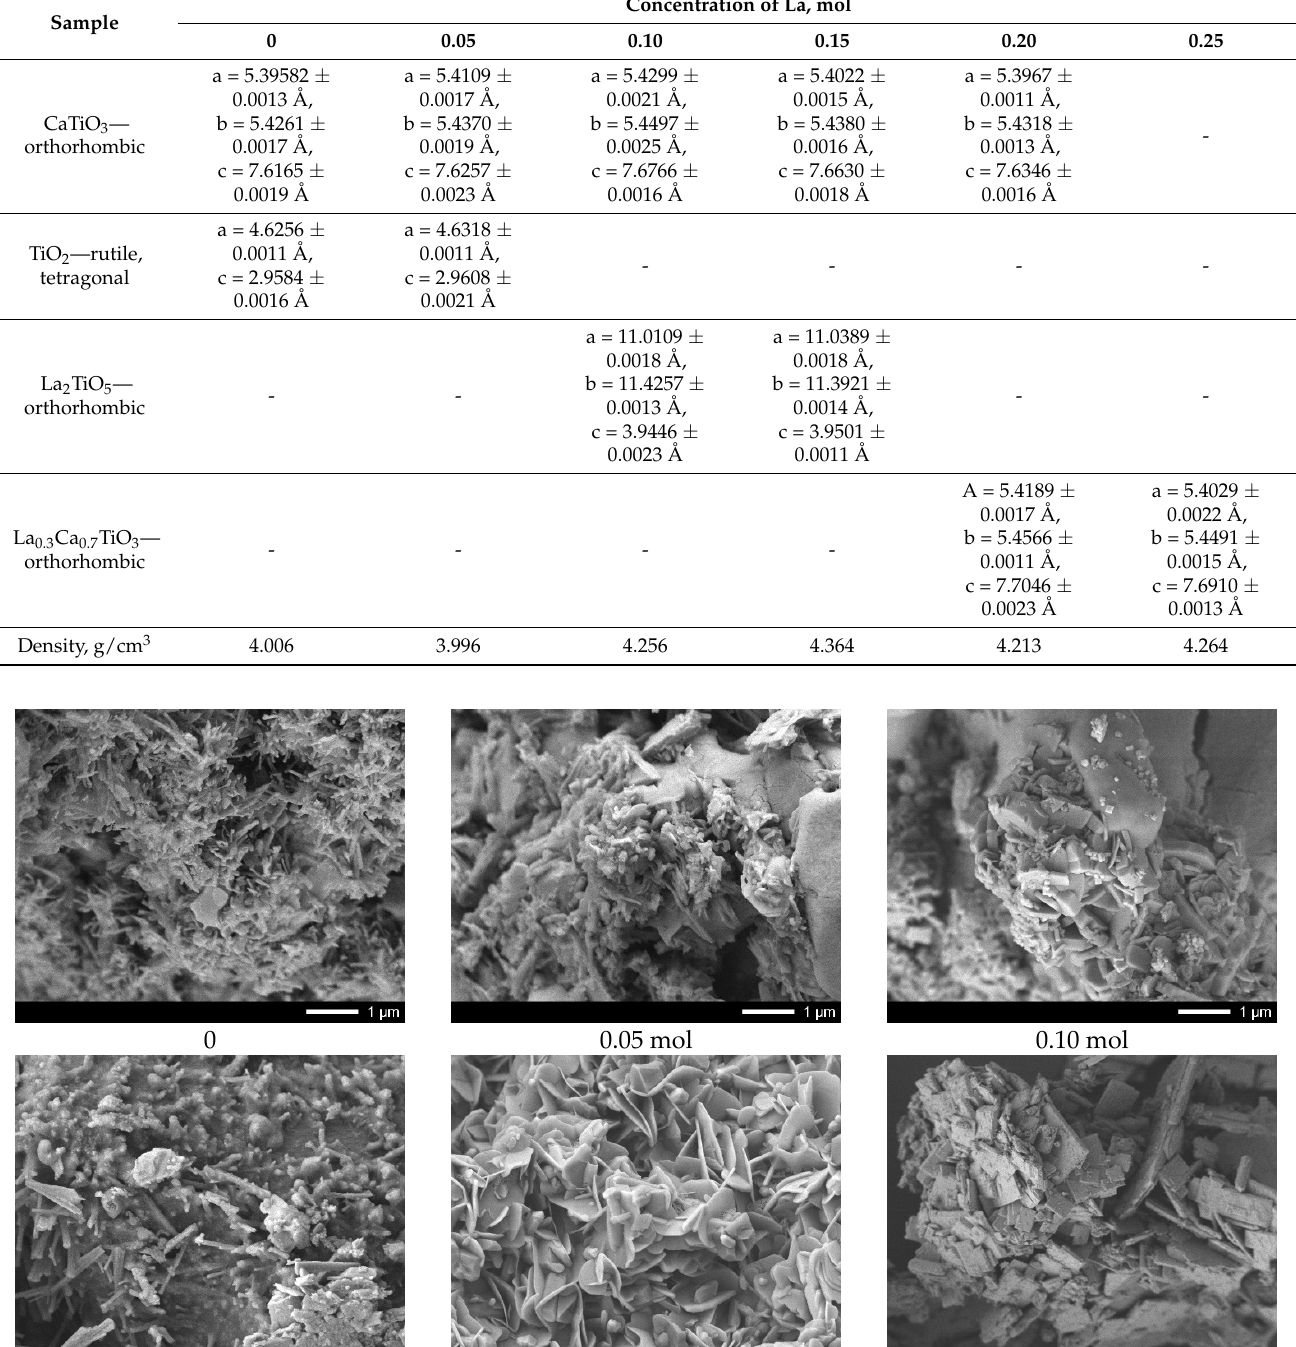
Table 1. Data of crystal lattice parameters.